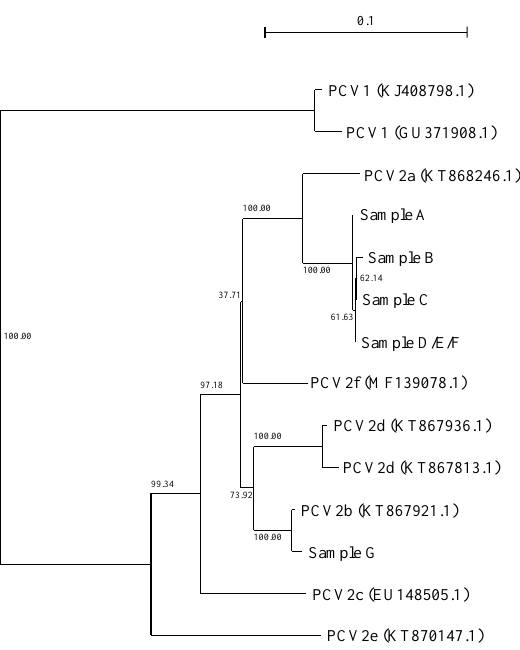
Figure 2. Phylogenetic tree of complete coding sequences of PCV2 capsid gene detected in the pig population (sample A–G) and representative sequences derived from different genotypes of PCV2 [35,36]. Birth dates of the samples and accession numbers in DDBJ/EMBL/GenBank nucleotide databases of the capsid gene sequences are as follows: A, 3 April 2007/LC637748.1; B, 29 October 2008/LC637749.1; C, D, E and F, 18 February 2009/LC637750.1, LC637751.1, LC637752.1, LC637753.1; G, 13 April 2012/LC637754.1. Bootstrap values for 10,000 replicates are shown as percentages beside the branches. The scale of the branch length is shown at the top of the figure. Table 2. Allele frequency of NOD2 -2197 in the Duroc population.